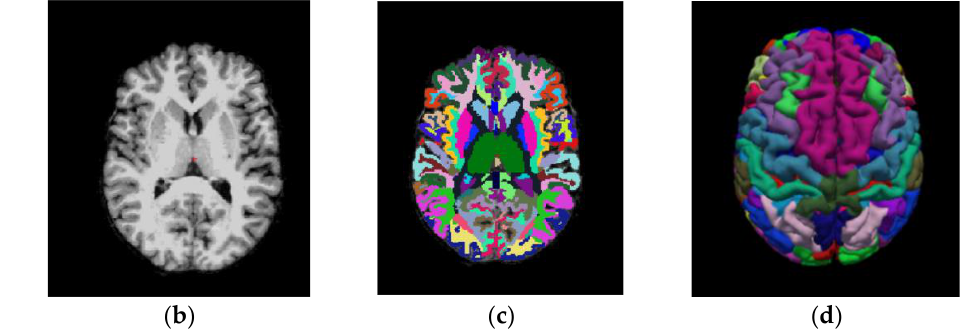
Figure 3. Coronal image of a patient from the study. ( a ) T1-weighted Magnetic Resonance Imaging (MRI—T1W). ( b ) MRI output after processing stages: Motion Correction and Conform, Intensity Normalization, Remove Neck and Skull Strip. ( c ) MRI output after applying Talairach transform computation and Cortical Parcellation Desikan-Killiany, an atlas that will permit us to obtain the values of Standard Uptake Value Ratio (SUVR) on the same patient from the PET image. ( d ) Three- dimensional reconstruction of the atlas from ( c ) using the color map of Desikan-Killiany atlas.